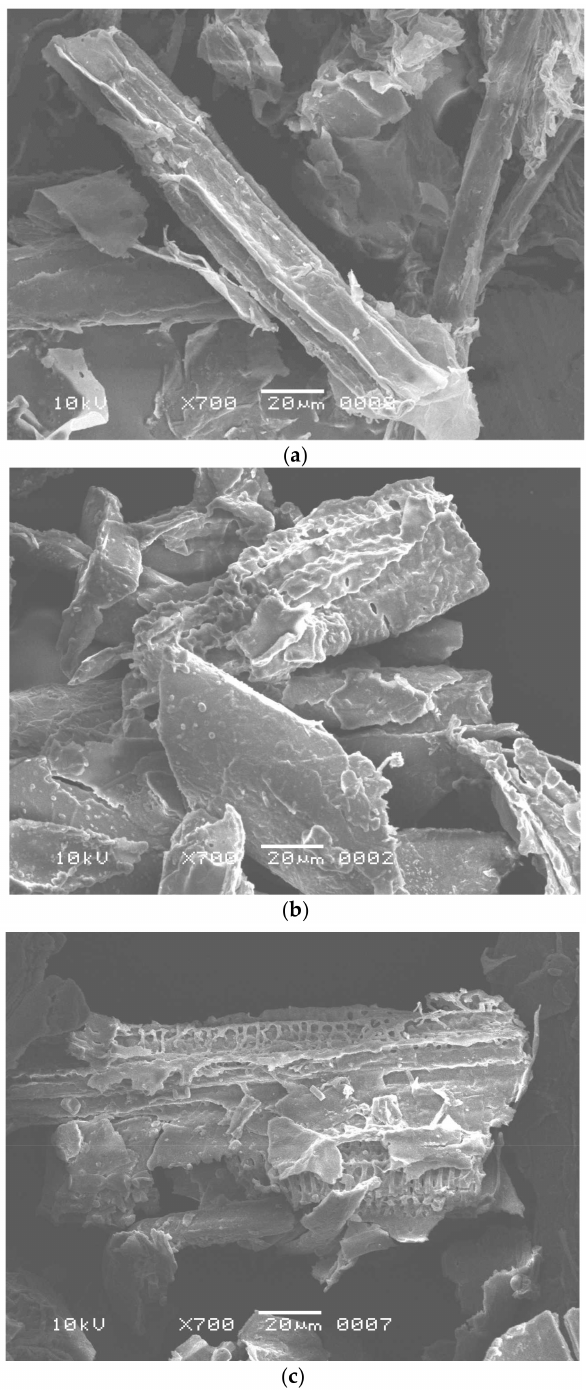
Figure 1. Scanning electron microscopy of ( a ) untreated sugarcane bagasse, ( b ) pretreated sugarcane bagasse, and ( c ) fermented sugarcane